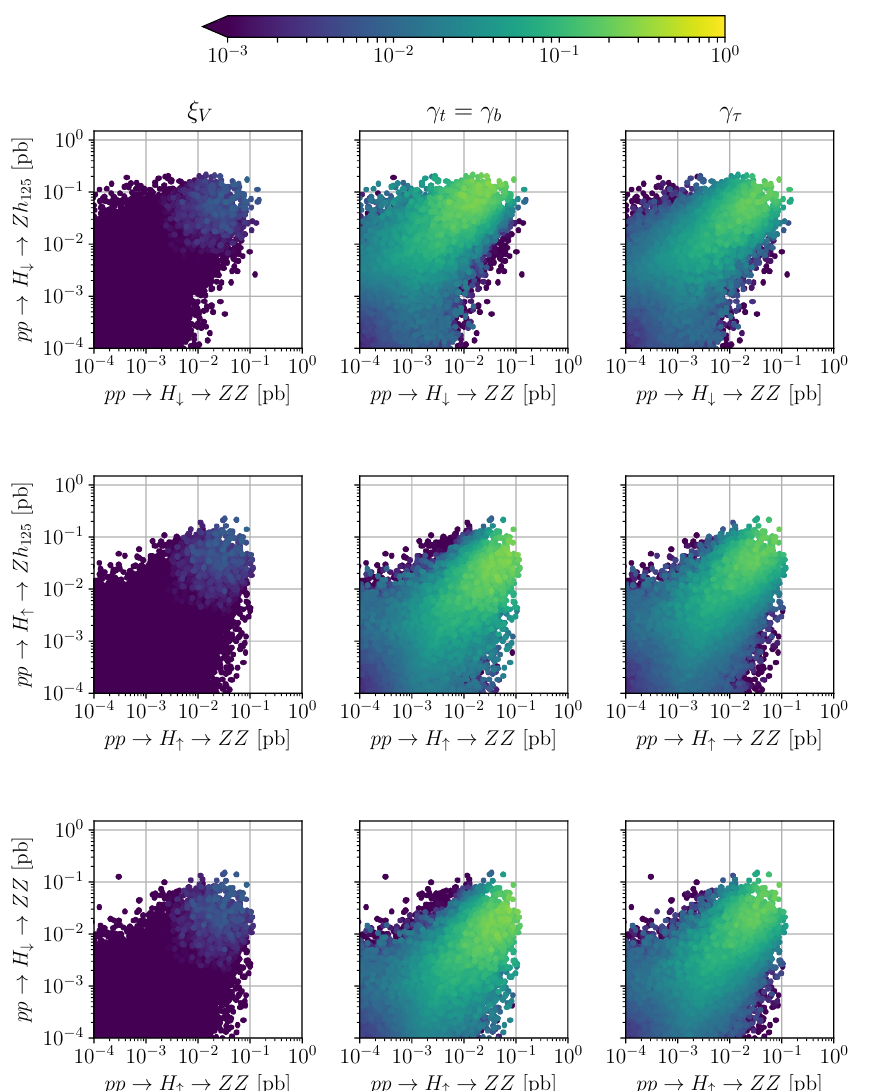
Figure 12 . Same as (cid:12)gure 11, but with signal strengths within 5% of the SM values, for Type II.